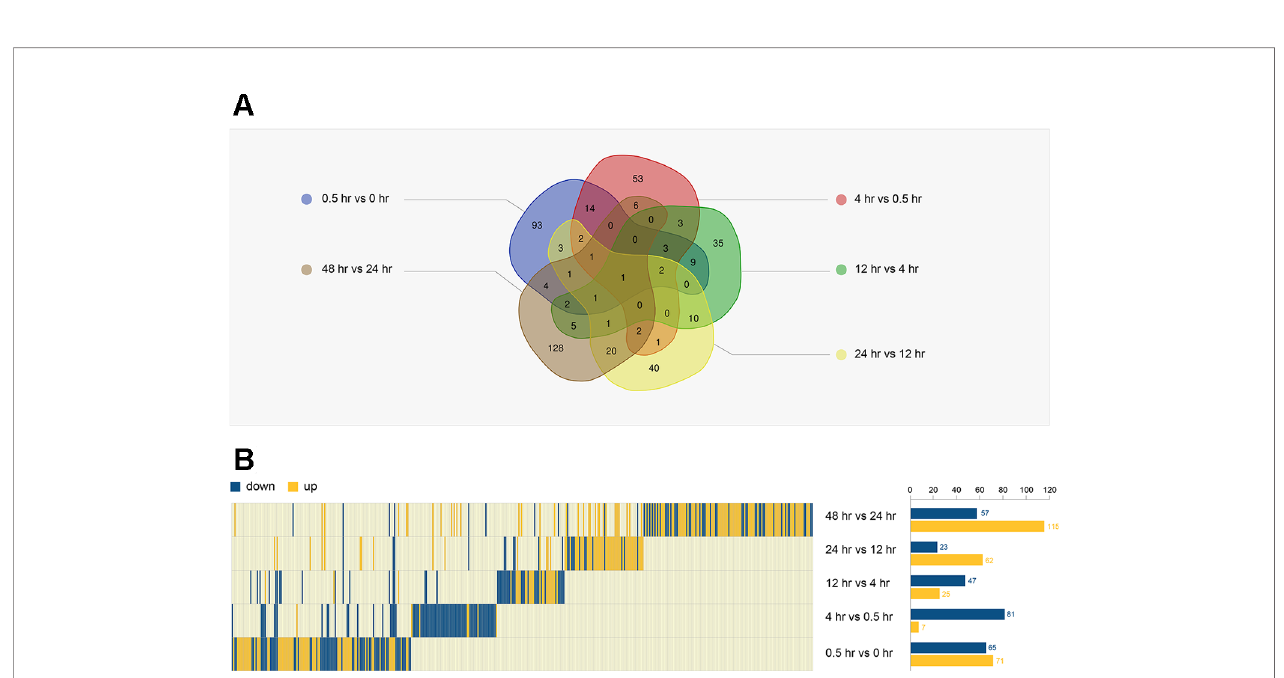
FIGURE 3 | Analysis of DEGs in fi ve groups. (A) The Venn diagram of fi ve DEGs. (B) The expression trend of all DEGs (440 genes) in the fi ve periods (left). The number of DEGs in each period is shown on the